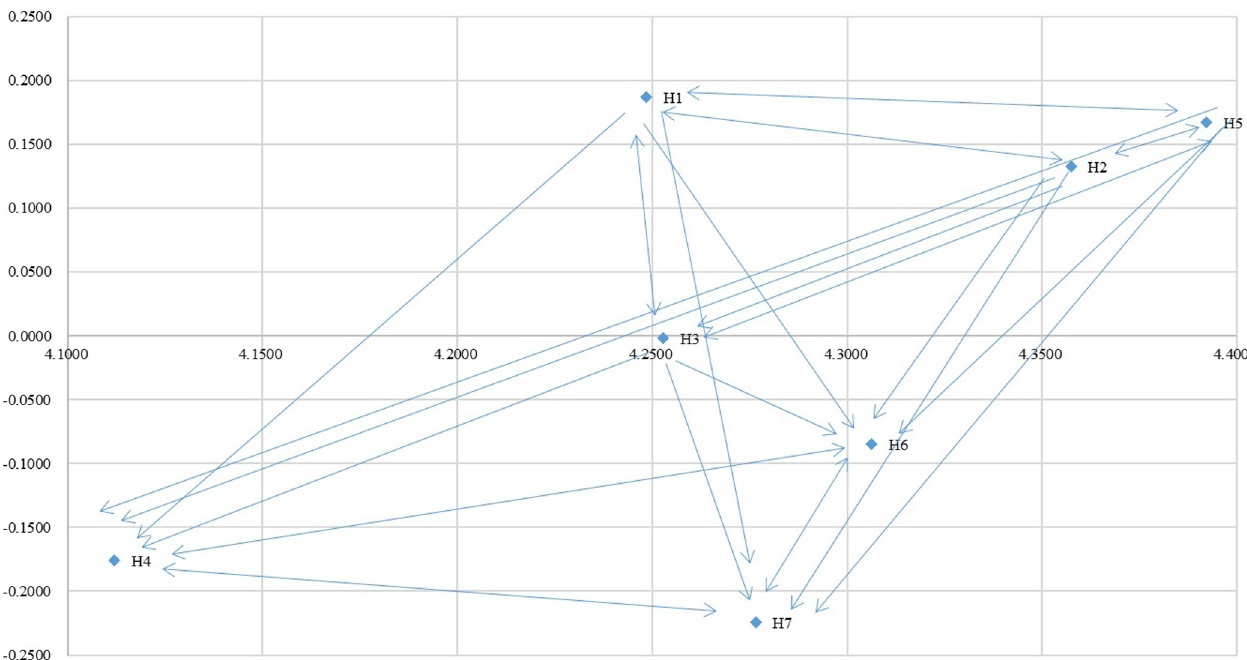
Fig 2. Network relationship map of influences among factors of DEMATEL. Budget (H1); Communication channel (H2); Benefits associated with participant (H3); Administration and management (H4); Leadership (H5); Self-efficiency (H6); Skills and Resources (H7).